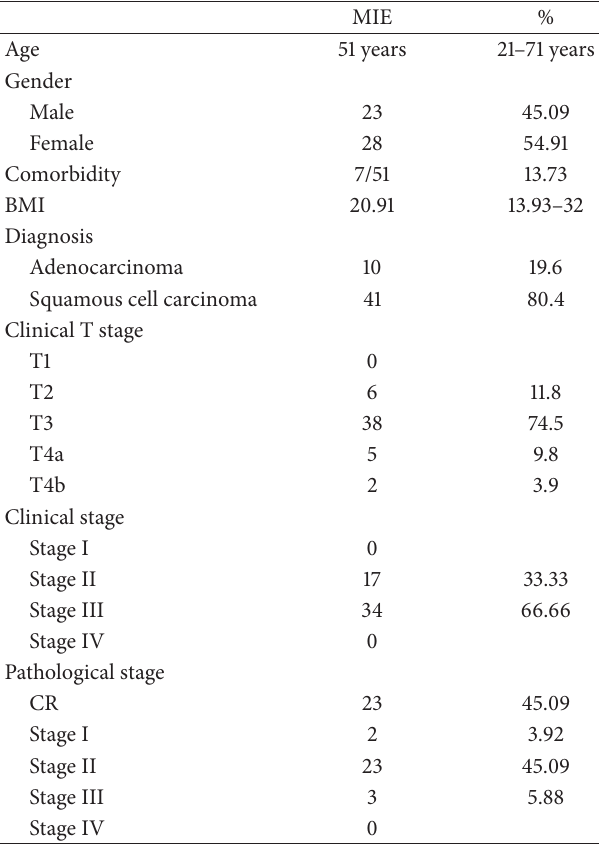
Table 1: Patient